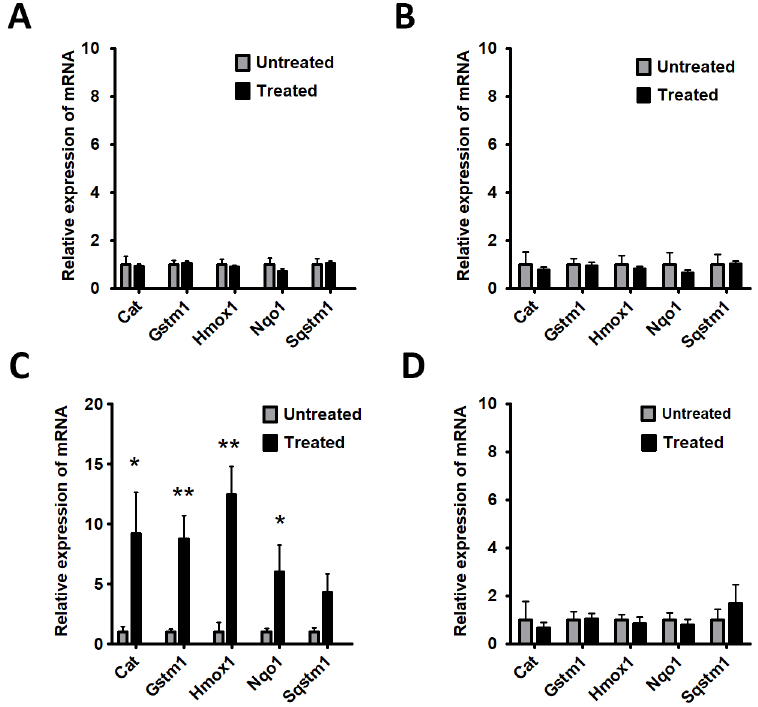
Fig 2. Zeaxanthin induces antioxidant response in the RPE. An experimental group (n = 5) receiving daily gavage feeding of zeaxanthin for one month did not exhibit induction of antioxidant genes such as Catalase ( Cat ), Glutathione S-Transferase Mu 1 ( Gstm1 ),Heme Oxygenase 1 ( Hmox1 ), NAD(P)H Quinone Dehydrogenase 1 ( Nqo1 ), and Sequestosome 1 ( Sqstm1 )in RPE/choroid (A) or retina (B) compared to control group (n = 5). However, after four months of supplementation, the experimental group had greater mRNA expression of the antioxidant enzymes in the RPE/choroid (N = 5:P < 0.05) than the control group (N = 5) (C); expression in the retina (D) was not affected by